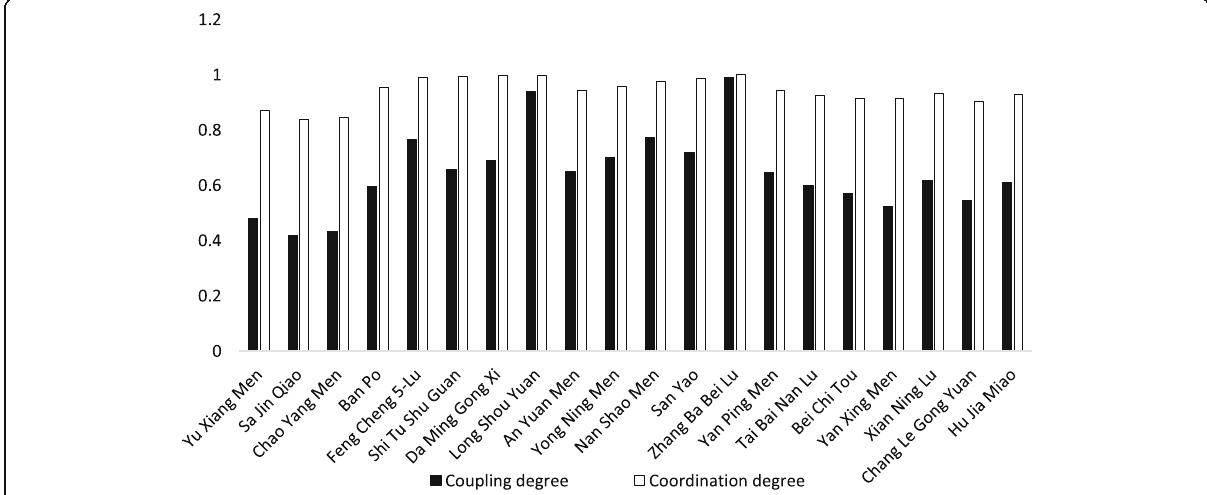
Fig. 3 Land use - rail transit capacity system coordination degree and coupling